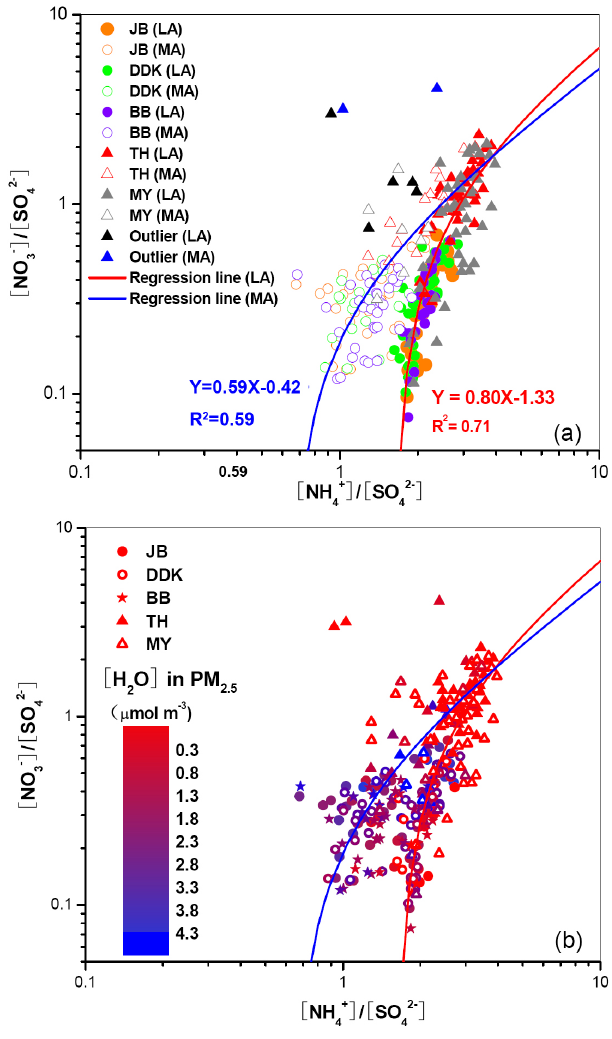
Fig. 8. Molar ratios of [NO − ent (a) acidity and (b) water content ([H 2 O]) in PM 2 . 5 at Beijing (TH and MY) and Chongqing (JB, DDK and BB). LA, less acidic. MA, more acidic.